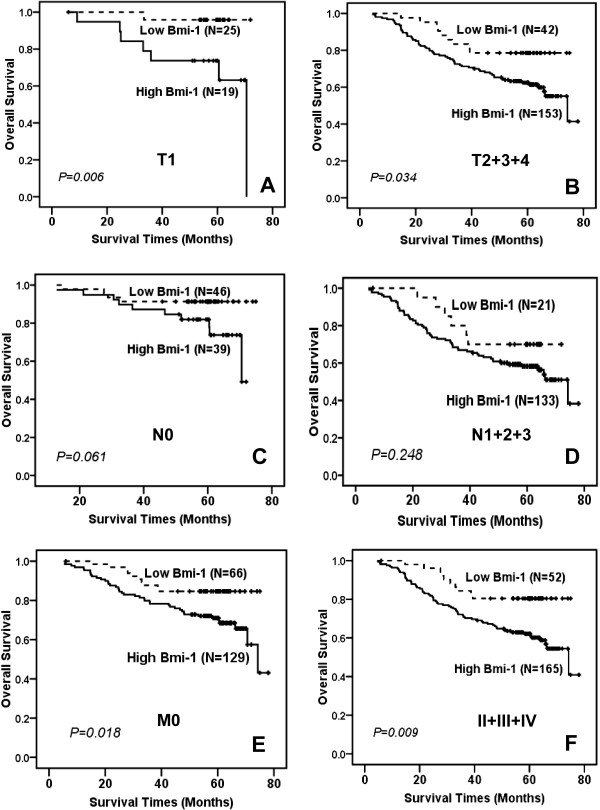
Kaplan-Meier curves of overall survival stratified by Bmi-1 status according TNM classification. (A, B) In each panel of patients with different tumor size, the overall survival was significantly shorter in the high Bmi-1 expression group than in the other group. (C, D) No obvious difference was seen according to the Bmi-1 expression in the N0 (C, P = 0.061) and N1+2+3 (D, P = 0.248) patients subgroups. (E, F) In the M0 panel and clinical stage II+III+IV panel, the overall survival was significantly shorter in patients with high Bmi-1 expression compared to those with low expression (E, *P = 0.018; F, P = **0.009).